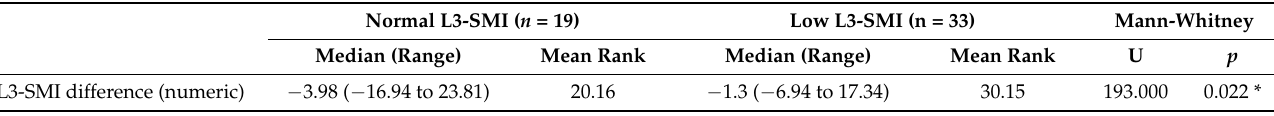
Table 4. Comparison of muscle mass dynamics after SVR between groups with low L3-SMI and normal L3-SMI at baseline.